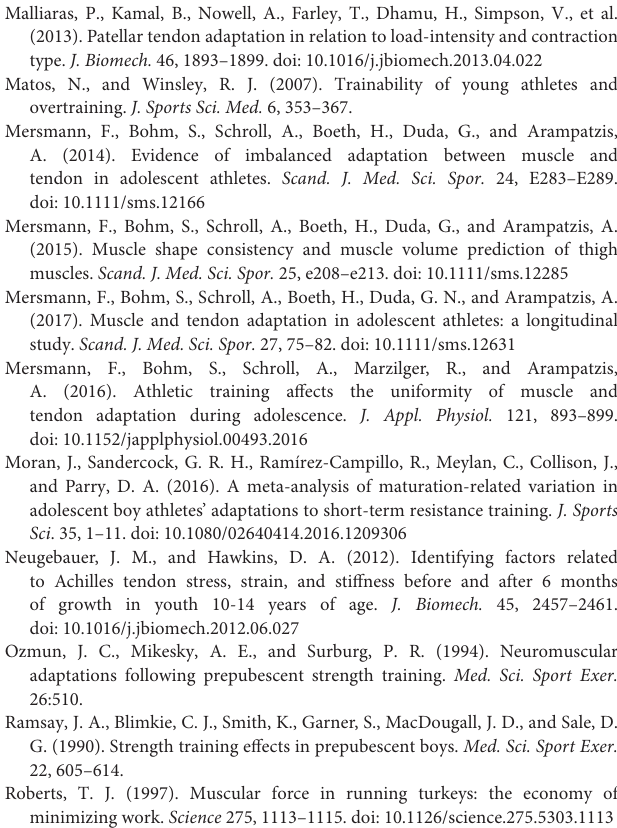
mRNA expression and protein synthesis. J. Biomech. 39, 2355–2362. doi: 10.1016/j.jbiomech.2005.08.008 Lavagnino, M., Arnoczky, S. P., Kepich, E., Caballero, O., and Haut, R. C. (2008). A finite element model predicts the mechanotransduction response of tendon cellstocyclictensileloading. Biomech. Model. Mechanobiol. 7,405–416. doi: